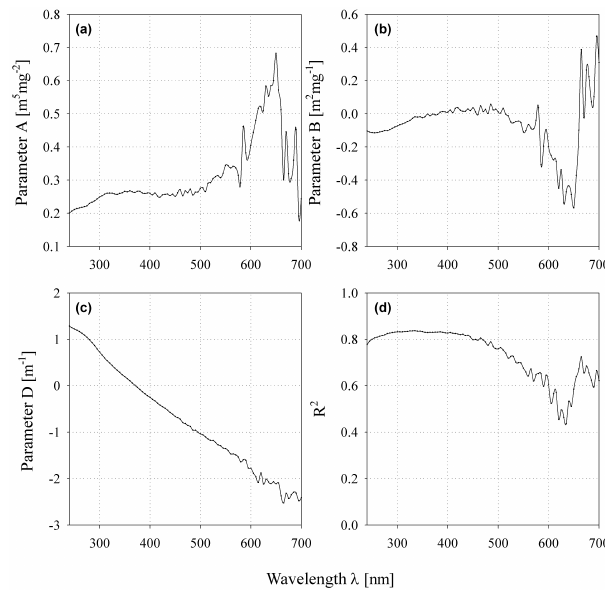
Figure 4. Spectral dependence of the model (expressed by Eq. 13) regression coefficients (a, b) , free term (c) and determination coef- ficient (d)